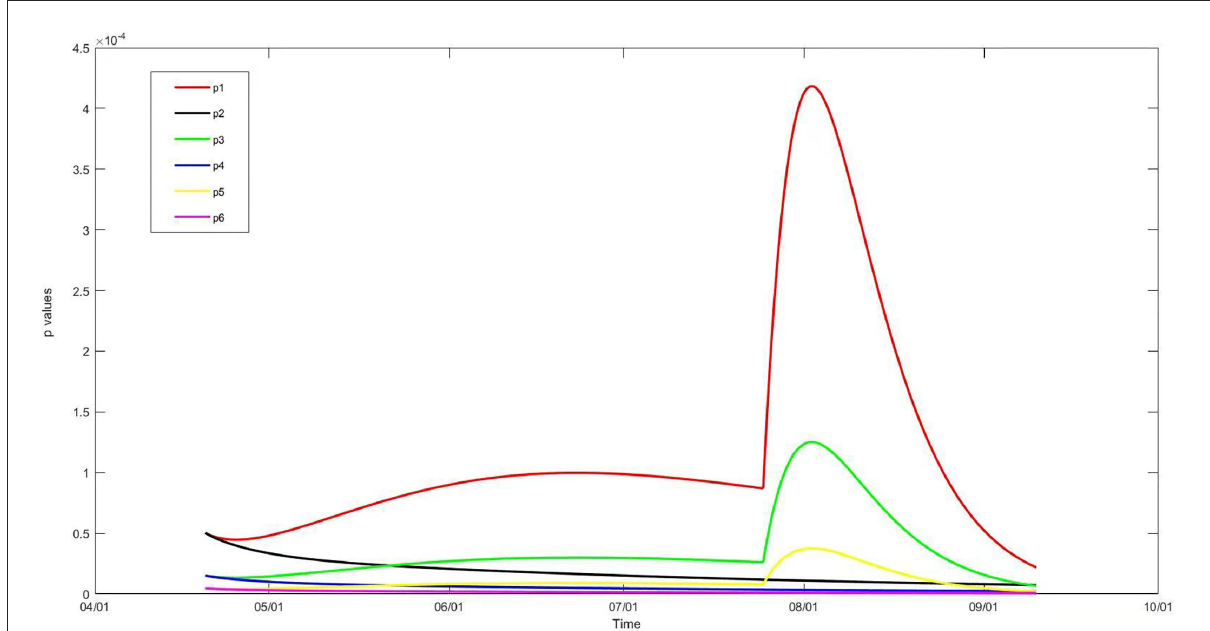
FIGURE3 Infection probability (p) in stadium, 20 April to 10 September. p1, without any preventive strategy; p2, with vaccination against COVID-19; p3, with a negative nucleic acid testing result within 7 days before admission; p4, with combined vaccination and nucleic acid testing; p5, with combined nucleic acid testing and face mask wearing; p6, with combined vaccination, nucleic acid testing, and face mask